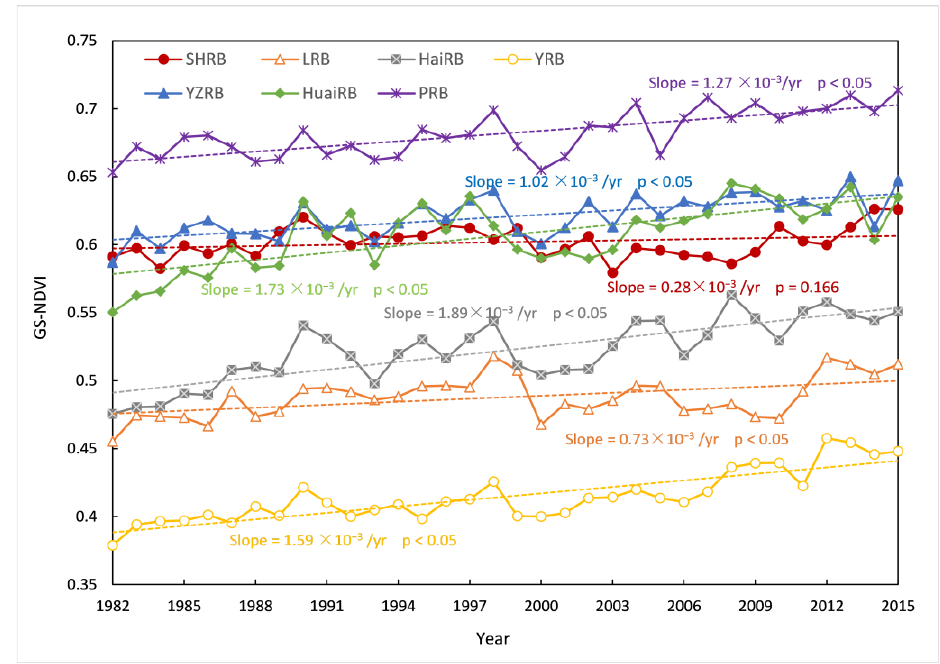
Figure 3. Inter-annual variation in the GS-NDVI in SHRB, LRB, HaiRB, YRB, YZRB, HuaiRB, and PRB from 1982 to 2015.